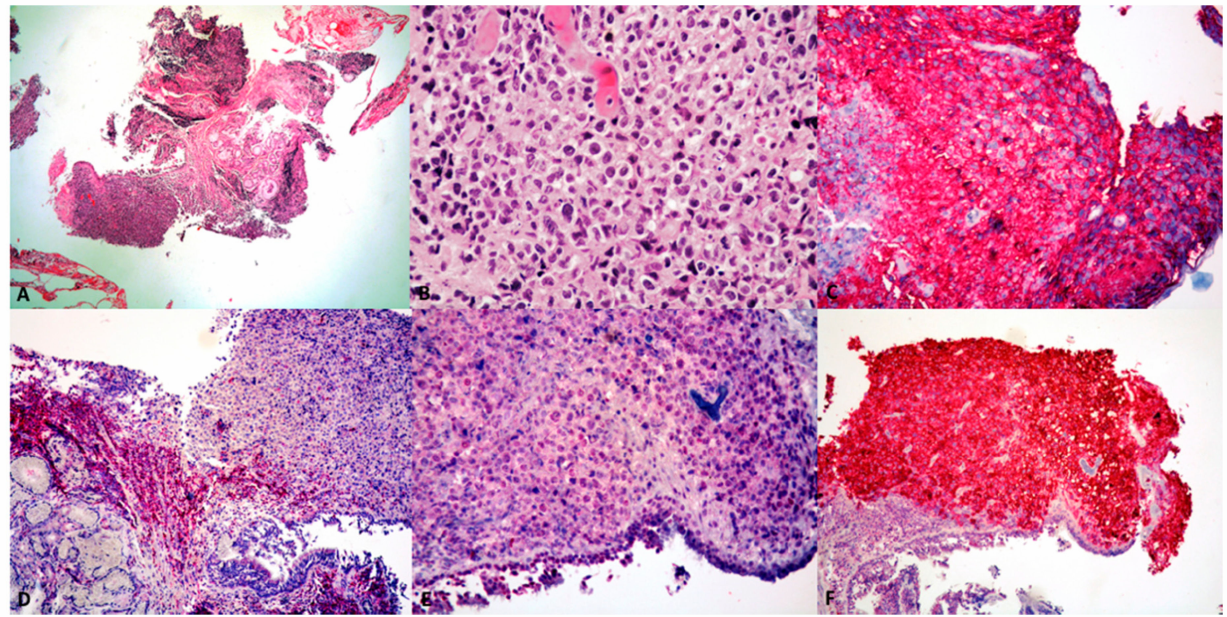
Figure 3. Primary pulmonary diffuse large B-cell lymphoma. ( A , B ). At low and high power, respectively, a heavy infiltrate of large tumor cell, the majority with centroblastic morphology (A H&E stain, 40 × ; B H&E stain, 400 × ). ( C , D ). Neoplastic cells show diffuse and intense expression of CD20, with fewer reactive CD3+ T-cells (( C ) CD20 immunostain, 200 × ; ( D ) CD3 immunostain, 100 × ). ( E ). In this GCB-type PP-DLBCL there is diffuse nuclear expression of BCL6 (BCL6 immunostain, 200 × ). ( F ). Tumor cells are intensely positive for CD30 in another case with immunoblastic morphology (CD30 immunostain, 100 ×